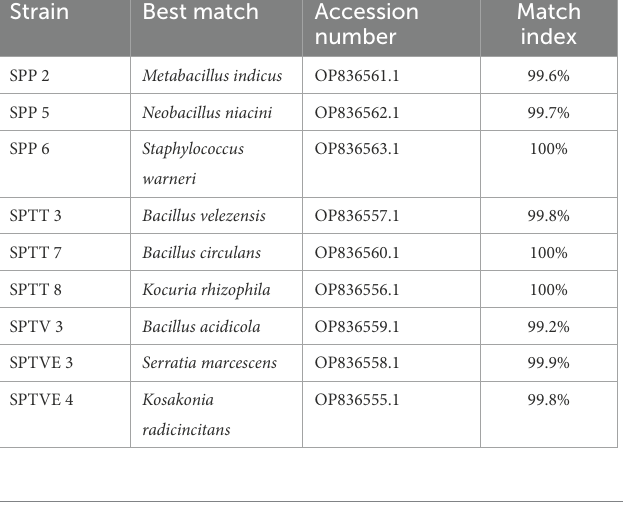
TABLE 2 16S rRNA identification of the halotolerant plant growth promoting bacterial isolates. Strain